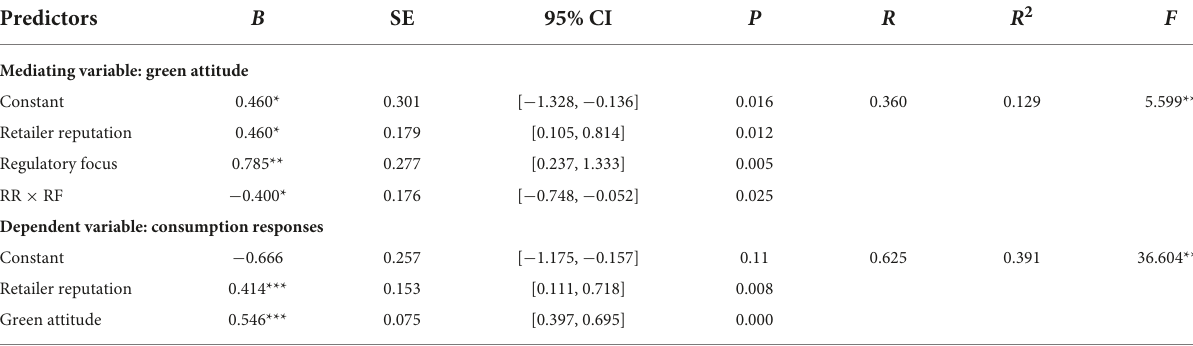
TABLE 2 Moderated mediation analysis: Effects of retailer reputation and regulatory focus on consumption response via green attitude.